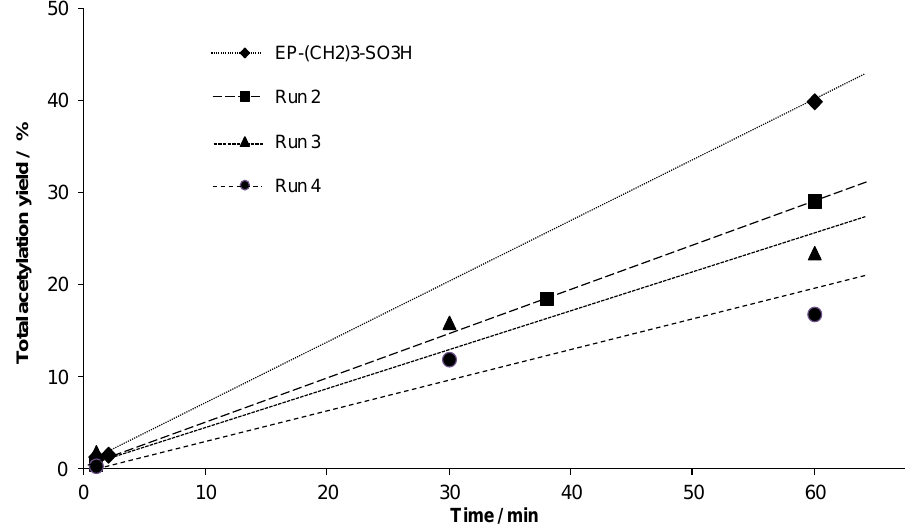
Figure 6. Recyclability experiments for EP–(CH first hour of the reaction. The lines are intended as visual aids only.